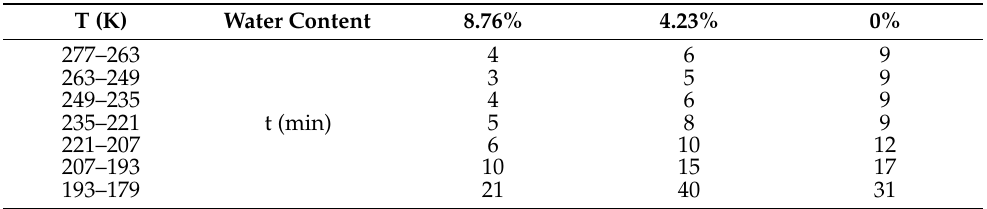
Table 3. The variation pattern of the time required to lower the same temperature at the measurement points of coal samples with a different water content (60